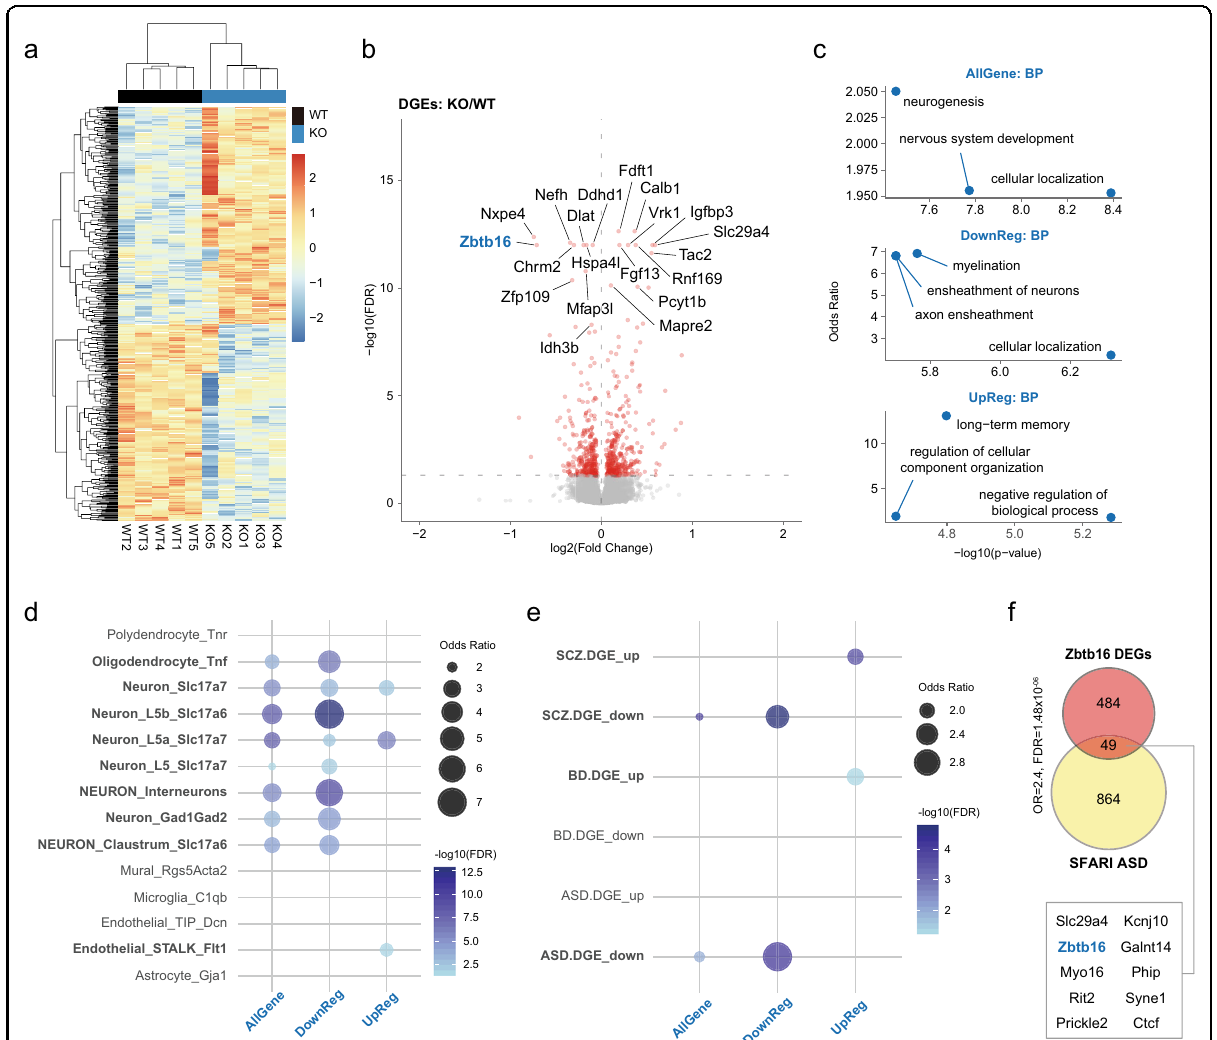
Fig. 4 The Zbtb16 transcriptome is enriched for ASD, SCZ, and cortical development-related genes. a Heatmap of differential expressed genes (DEGs) in mouse PFC. b Volcano plot showing Zbtb16 DEGs with the top 20 gene names indicated. FDR < 0.05, Y -axis = − log10(FDR), X -axis = log2 (Fold Change). c GO analyses of Zbtb16 DEGs in biological process (BP). Scatterplots represent the top 3 functions in each module. Y-axis = Odds Ratio, X -axis = − log10( p -value). AllGene: all DEGs, DownReg: downregulated DEGs, UpReg: upregulated DEGs . d Zbtb16 DEGs are enriched in neurons and oligodendrocyte. Dot plots of Zbtb16 DEGs showing the cell-type-speci fi c enrichments. Zbtb16 DEGs, in particular, the downregulated DEGs are highly enriched in Slc17a7 + , Slc17a6 + , and Gad1 + Gad2 + neurons, interneurons, and oligodendrocytes. In contrast, the upregulated DEGs are enriched in Slc17a7 + neurons and endothelial cells. Dot plots represent the Odds Ratio. Colors represent the − log10(FDR). e Dot plots of Zbtb16 DEGs showing the enrichment for disorder-speci fi c human transcriptome. Downregulated Zbtb16 DEGs are enriched in ASD and SCZ downregulated genes. In contrast, upregulated Zbtb16 DEGs are enriched in bipolar disorder and schizophrenia upregulated genes. SCZ: schizophrenia, BD: bipolar disorder, ASD: autism spectrum disorder . f Venn diagram of Zbtb16 DEGs overlapping with SFARI ASD genes. The overlapping top 10 genes are highlighted. n = 5/condition for